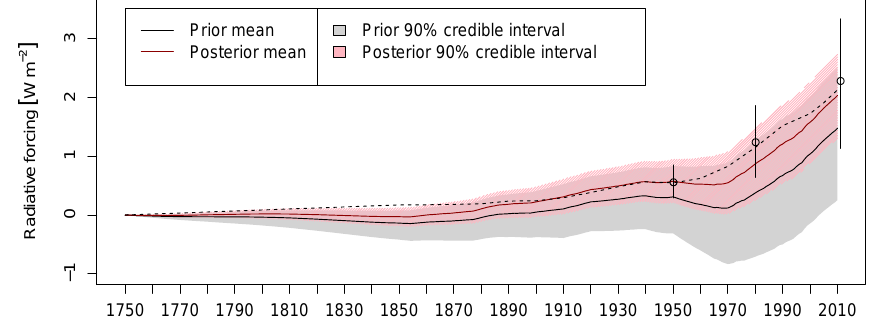
Fig. D2. Prior and posterior distribution of the time series for anthropogenic RF from the main analysis. Red colour for the posterior distribution and black lines and grey shadings for the prior distribution. The dashed line is the historical RCP total RF (http://tntcat.iiasa.ac.at: 8787/RcpDb/) and the three error bars are the total anthropogenic RF values in 1950, 1980 and 2011 from IPCC AR5. The error bars indicate the very likely range ( >